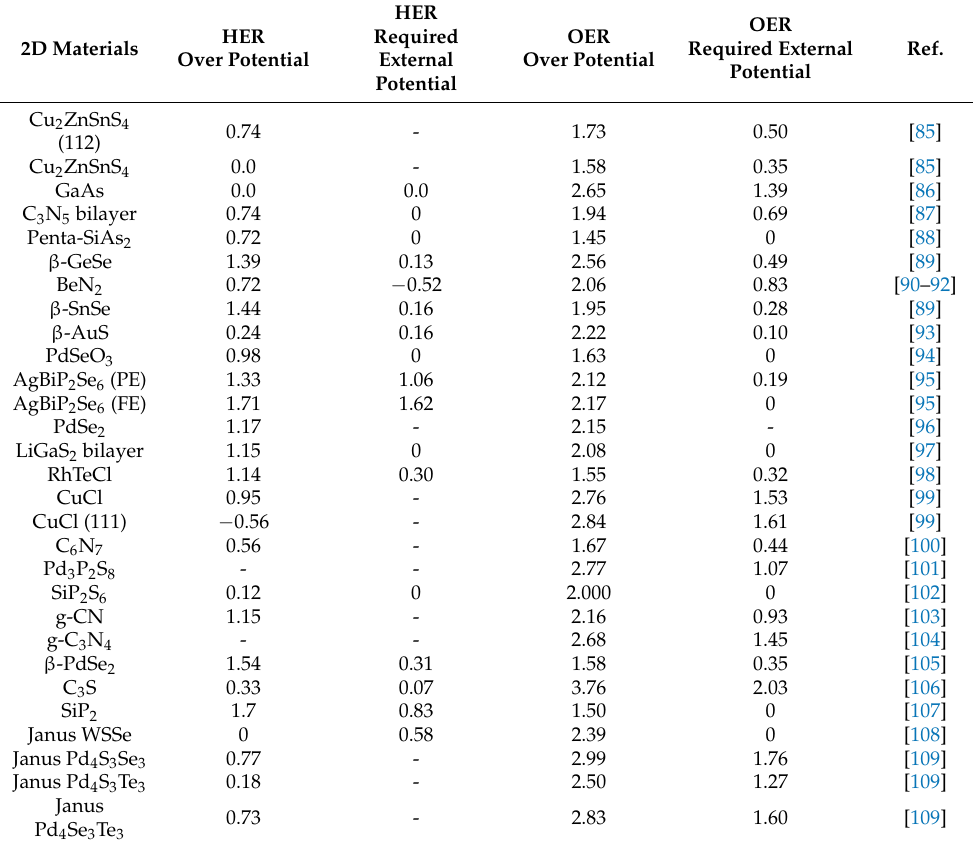
Table 1. Overpotential and required external potential for HER and OER for 2D materials.